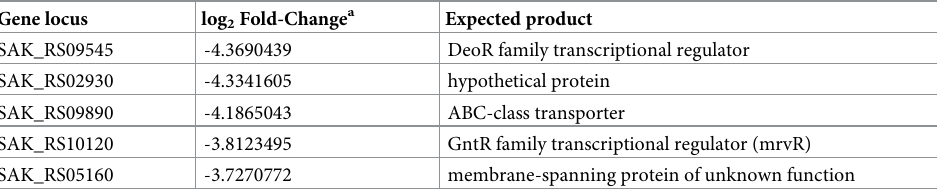
Table 1. GBS genes conditionally essential for survival in human amniotic